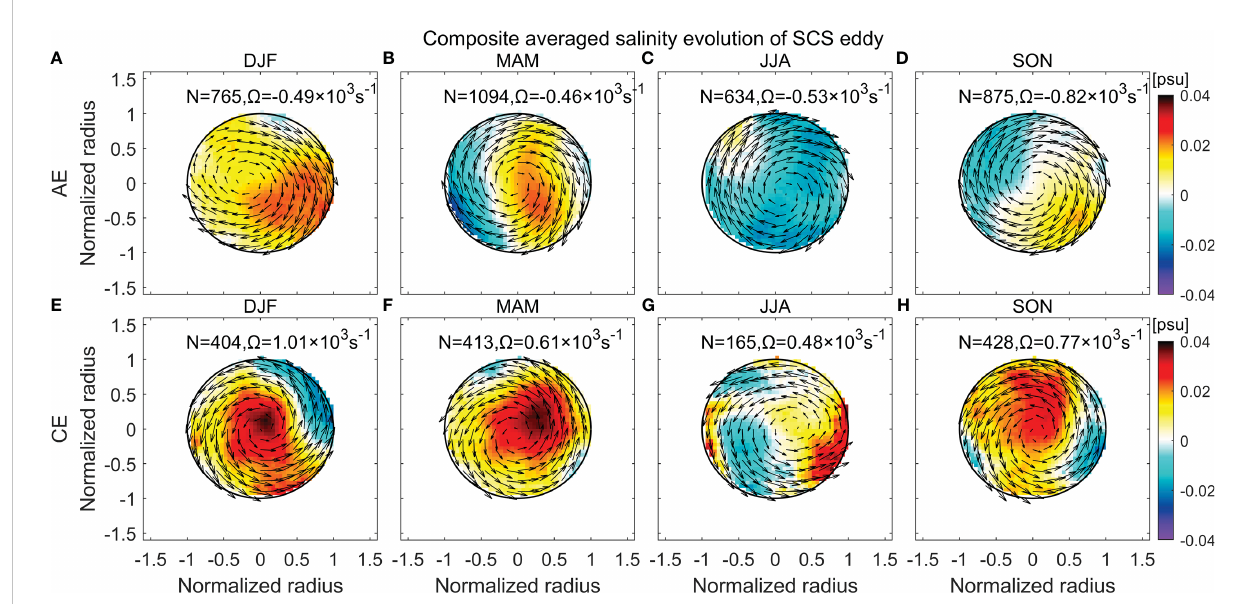
FIGURE 4 The seasonal evolution of the AE (A-D) and CE (E-H) eddy composites. The shading and vectors are the salinity anomaly (shading, unit: psu) and current anomaly (vector, unit: m·s -1 ), respectively. The number of eddy samples and eddy vorticity ( W ) are marked on each